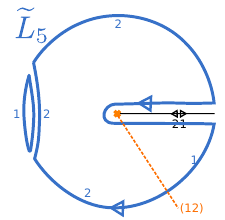
Figure 41 . A more explicit picture of the lifted path e L 5